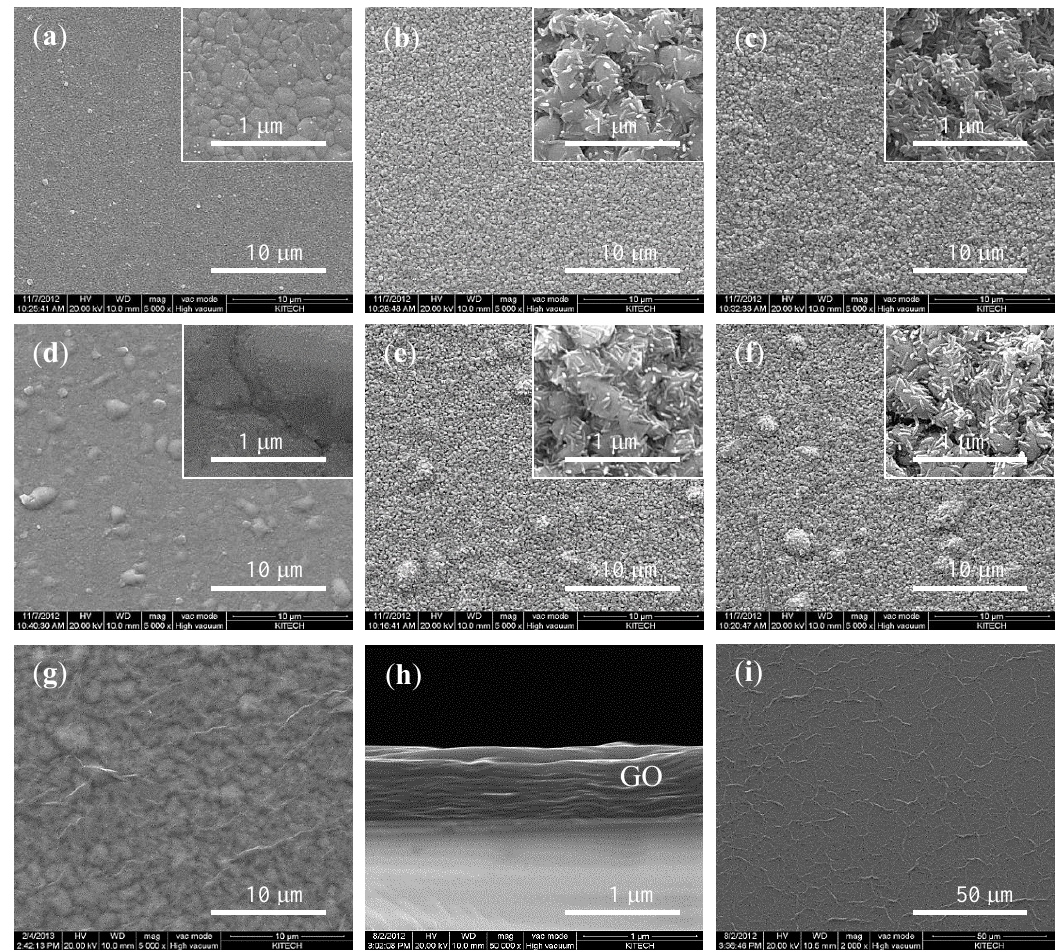
Figure 3. Changes in the surface morphology of the electrode as observed using SEM: ( a – c ) non-heat-treated electrodes and ( d – f ) electrodes heat-treated at 320 °C. (The magnification of the images in ( a – g ) is × 5 K, that for images in the insets of ( a – f ) and ( h ) is × 50 K, and that for the image in ( i ) is × 2 K. Images of the Ag and Ag/AgCl thin films after the following steps are shown: ( a ) before the heat treatment, ( d ) after the heat treatment, ( b , e ) after chlorination with 50 mM FeCl 3 , and ( c , f ) after overnight storage in a saturated AgCl solution. ( g ) GO layer on a ready-to-use electrode. ( h ) and ( i ) show cross-sectional and top views of the pristine GO layer,